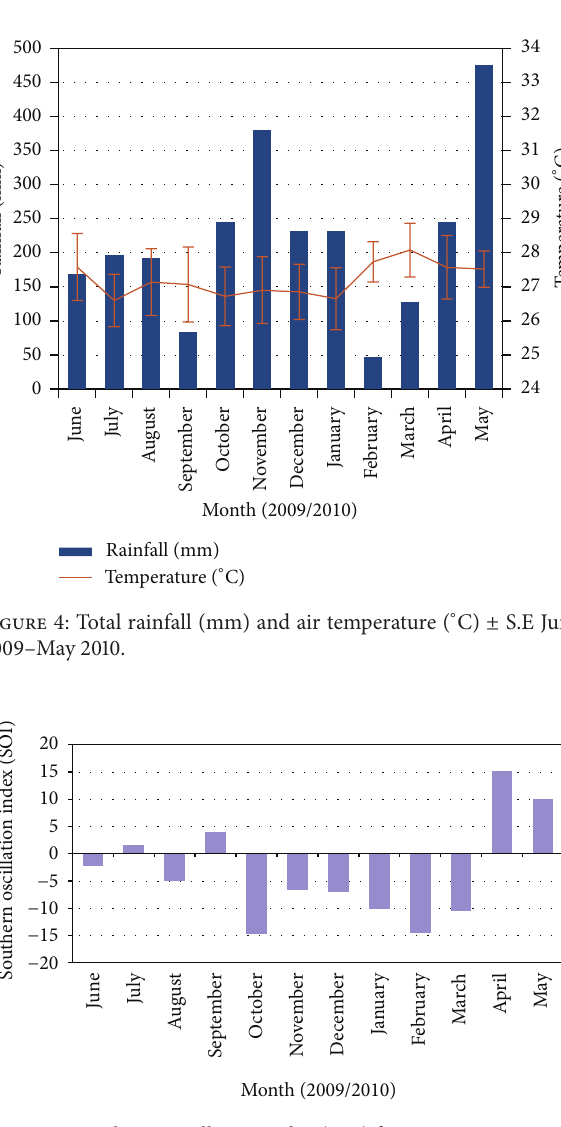
Figure 5: Southern Oscillation Index (SOI) from June 2009 to May